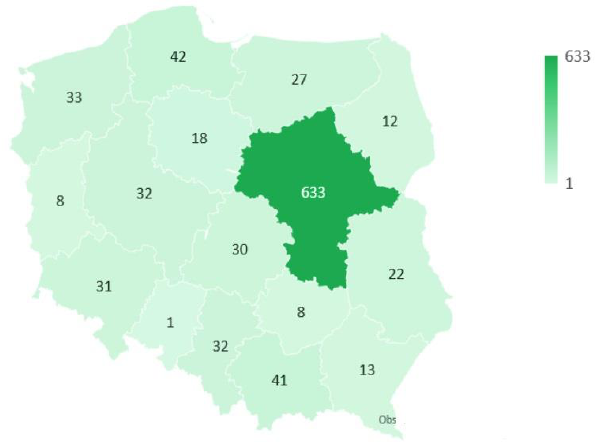
Figure 6. Regional distribution of the respondents’ residence among the different voivodeships in Poland. (source: own elaboration with the use of GeoNames).